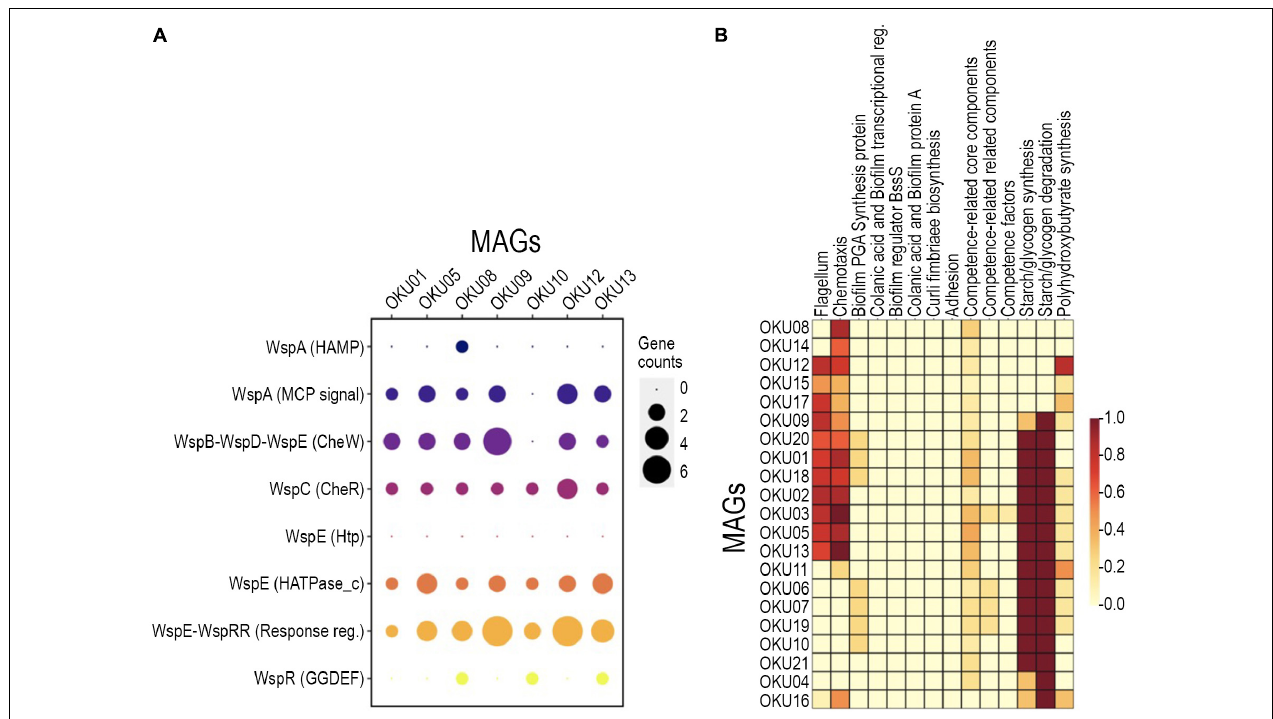
FIGURE 6 | Detected biofilm formation genes across MAGs with detected annotation matches in WspGenie analysis (A) and biofilm formation genes in KeggDecoder analysis (B) . Gene counts were compared against contig gene count in